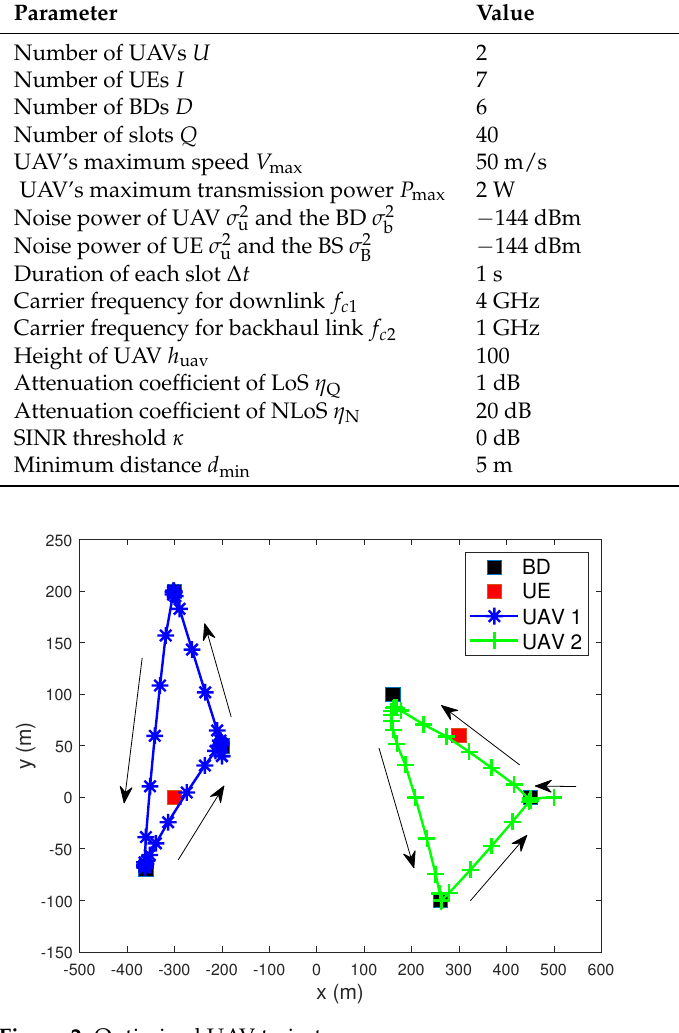
Figure 2. Optimized UAV trajectory.